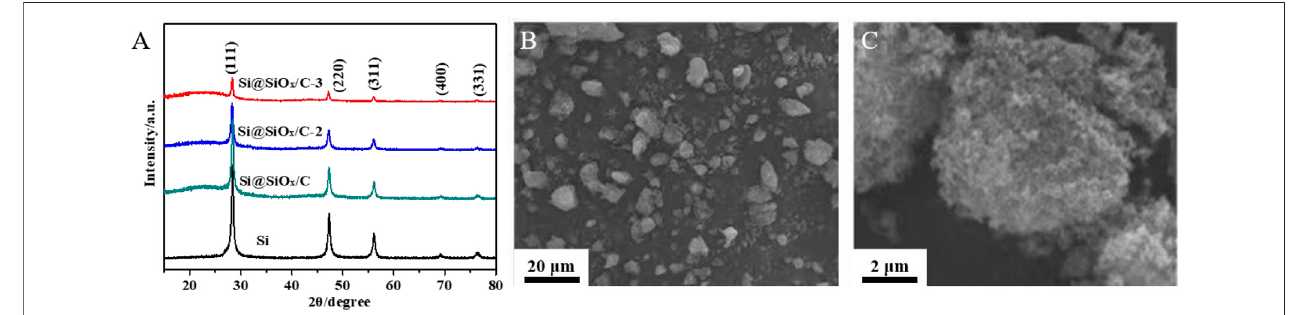
FIGURE3| TEMimagesof (A,B) Siand (C,D) Si@SiO x /Cmaterials. (E) TEMimageandcorrespondingEDSmappingofSi,C,and OelementsinapartialSi@SiO x / C particle.